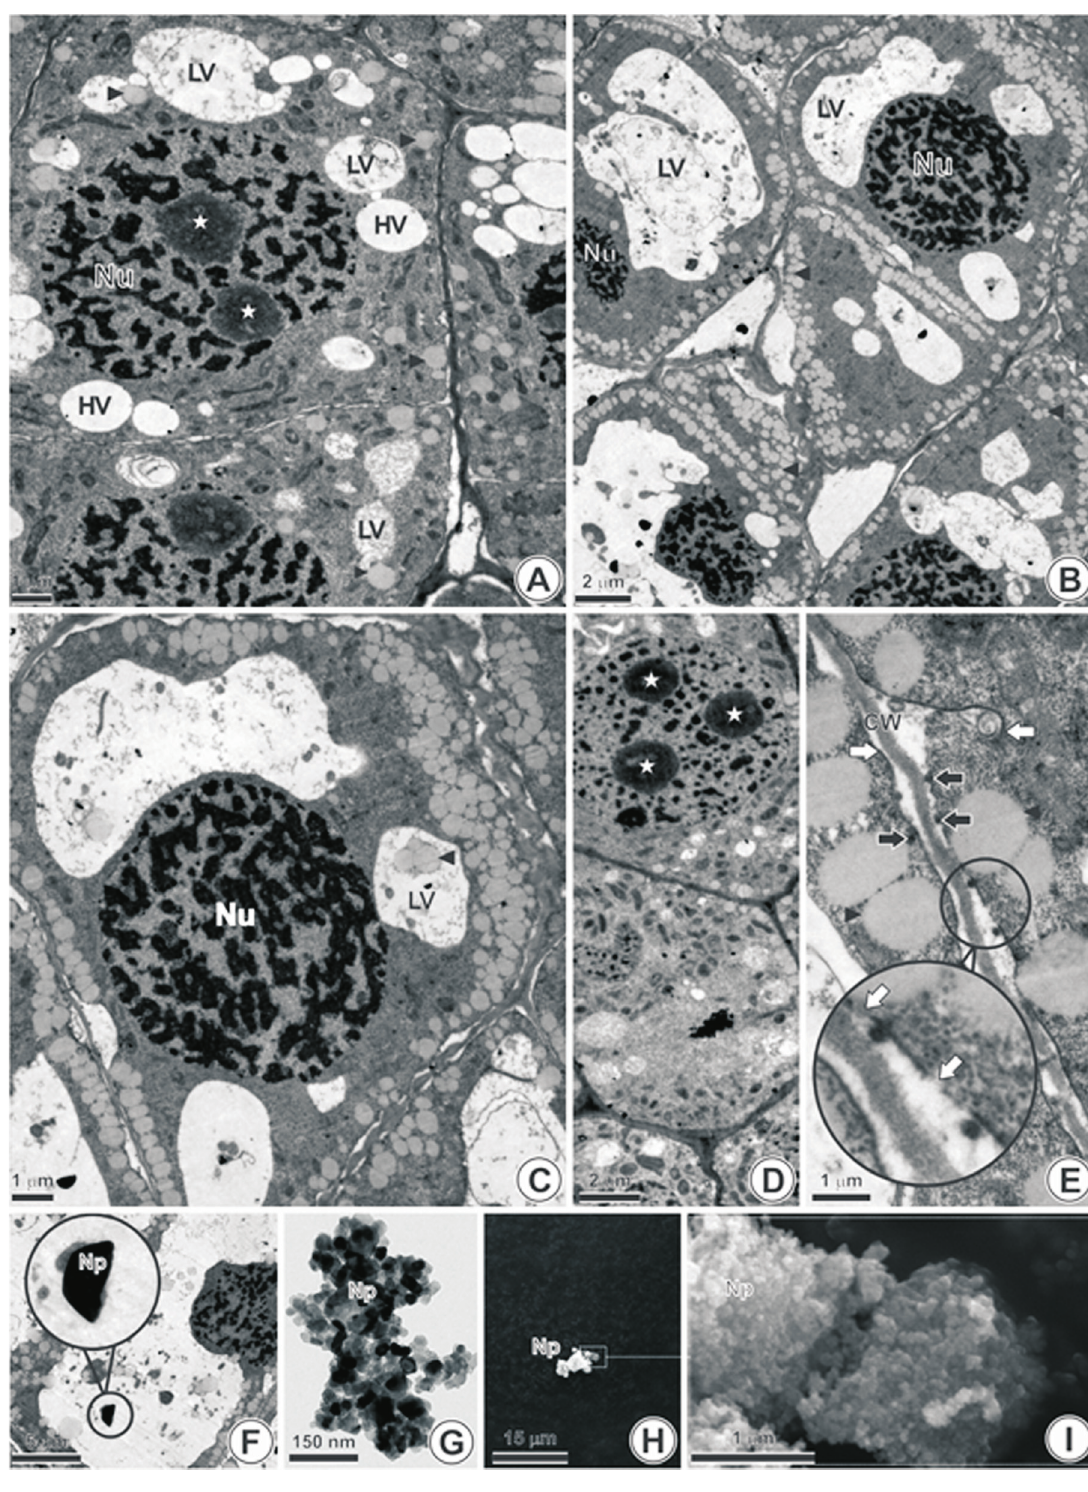
Figure 4 - Root tip of Allium cepa (longitudinal sections) observed in transmission electron microscope. (A) Negative control and cells exposed to 1000 mg/L TiO 2 NP (B-E). Suspension of 1000 mg/L TiO 2 NP observed by selected area electron diffraction analysis (SAED) in transmission electron micro- scope (F-G) and scanning microscope (H-I). (A) Cell with lytic vacuole (LV) and hyaline (HV), and nucleus (Nu) with two nucleoli (star). (B) Increase in the volume and number of lytic vacuoles and increased volume of oil bodies (arrowhead). (C) Large number of oil bodies (arrowhead) in the adjacencies of plasma membrane and within the lytic vacuoles. (D) Nucleus with three nucleoli (star). (E) Rupture of the plasma membrane (white arrow) and elec- tron-dense corpuscles associated with the plasma membrane (black arrow). Abbreviations: CW (cell wall). (F) Internalized TiO 2 NP in the vacuole with 450nminthebrookitephase.(G)CharacterizationoftheTiO 2 NPsuspensioninTEM.(H)CharacterizationofTiO 2 NPinscanningmicroscope–500x.(I) Characterization of TiO 2 NP in scanning microscope, 50,000